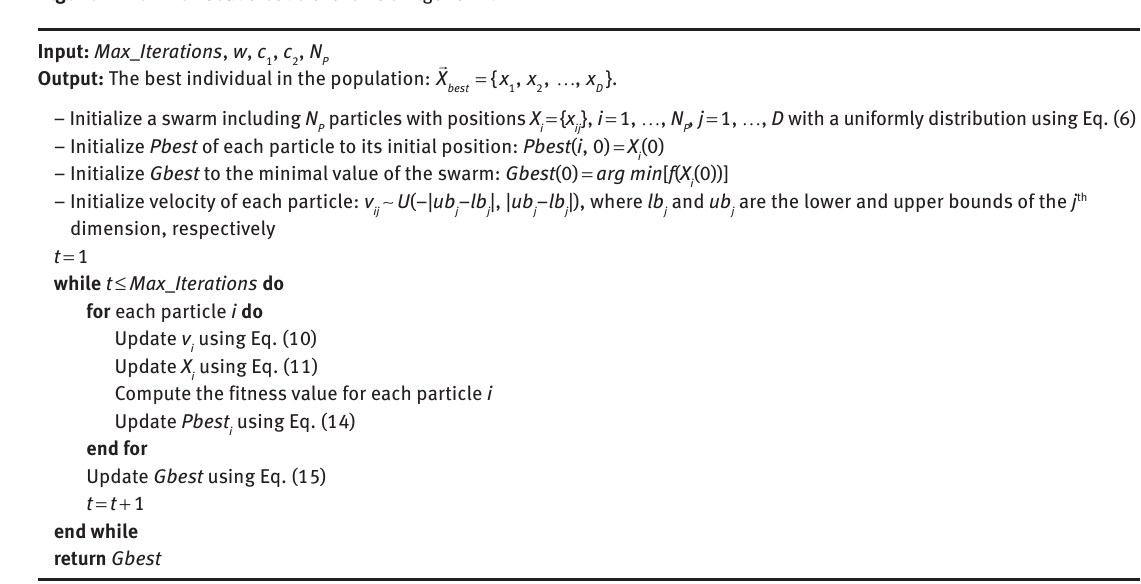
Algorithm 2: The Pseudo Code of the PSO